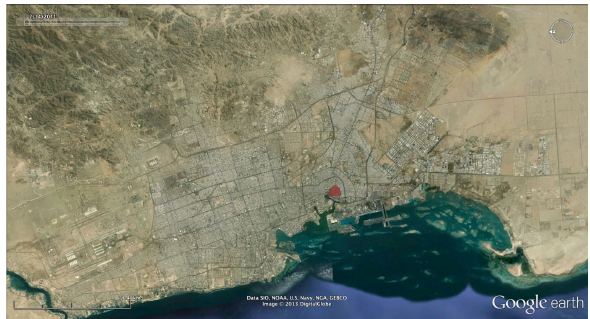
Figure 1, Old Jeddah (red) in the centre of modern Jeddah For the workshop the area within the boundaries of Al Balad was selected for the research at urban scale. The detailed building survey was realised in a house situated close to the Baladia, named Al Nawar House. These records were accompanied by a rough survey of one of the most well known buildings of Old Jeddah, the Noor Wali House. According to this choice the area including Al Nawar House, Naseef House and Noor Wali House was the place for work concerning the neighbourhood